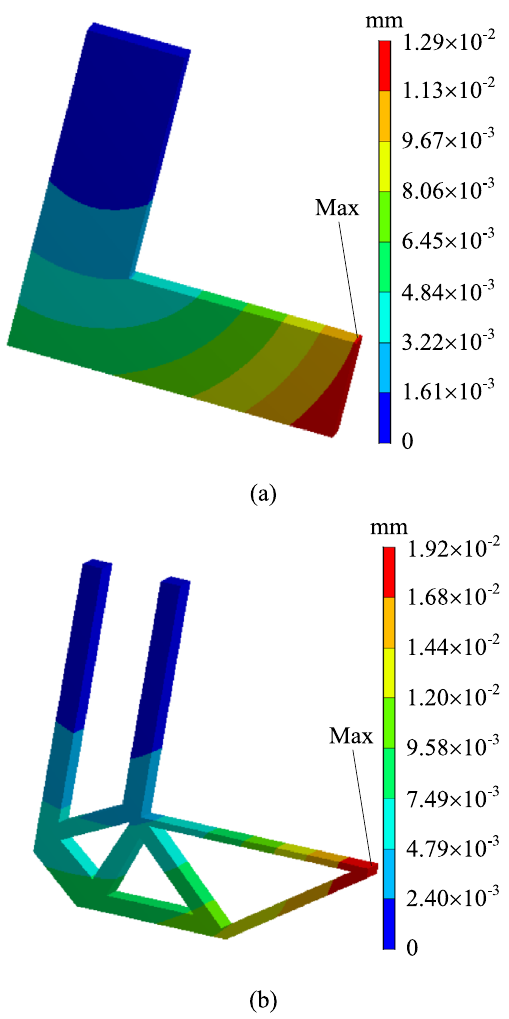
Figure 8. Comparison of displacement contour figures before and after optimization. ( a ) Displacement contour figure of the original model ( b ) Displacement contour figure of the reconstructed